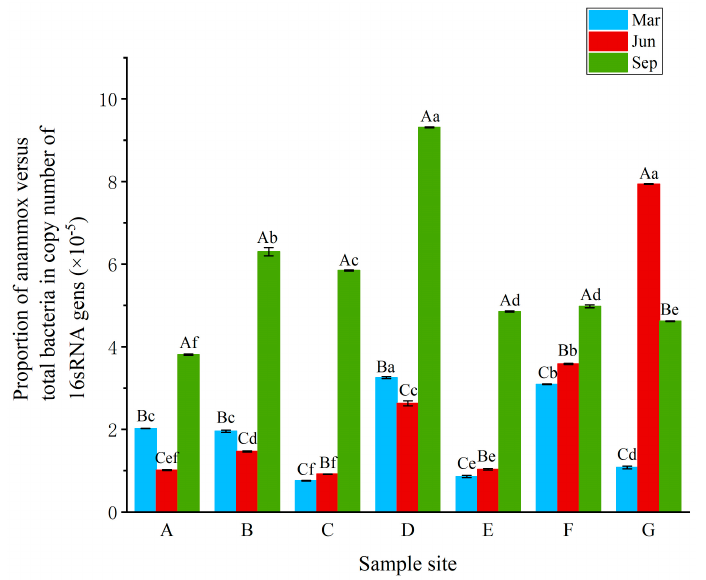
Figure 3. The relative abundances of the anammox bacteria in the RPAS. Letters: a significant dif- frerence. Table 4. Quantification of anammox and total bacterial 16S rRNA gene copies in the RPAS.